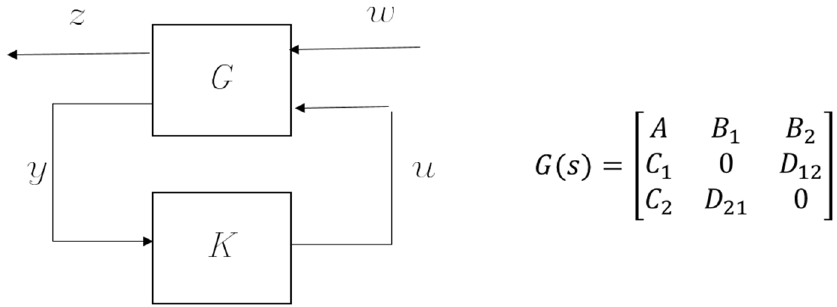
4 of 14 Figure 2. Lumped-parameter model of the positioning system. Sweep sinusoidal signals are selected to test the response of the built positioning sys-